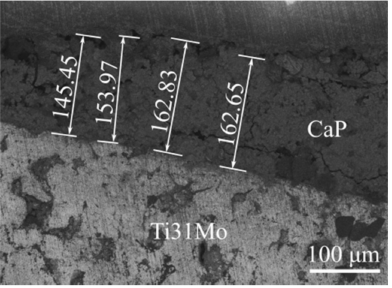
Figure 4. Cross-section view of CaP surface layer for Ti31Mo after hydrothermal